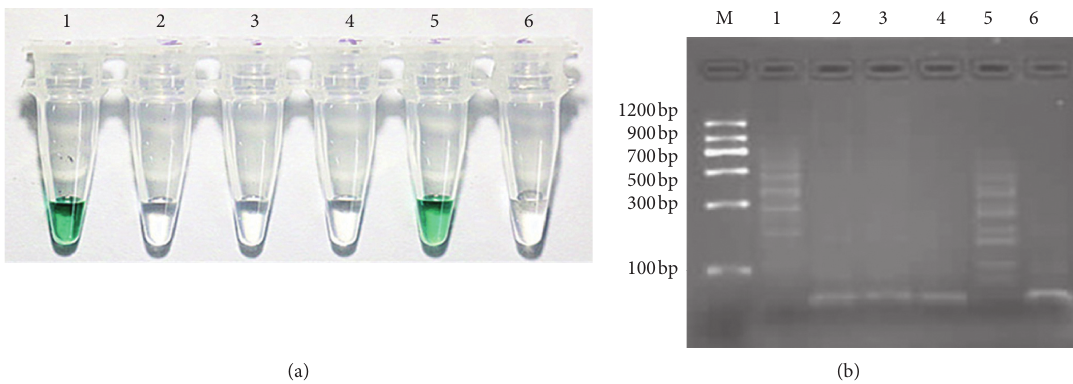
Figure 1: Colorimetric detection of the GmSg-1 a and GmSg-1 b using the HCR assays. (a) The photograph illustrates the colorimetric results of tubes 1–6 by adding different hairpin probes and target genes. Tube 1: GAa1+GAa2+TAa. Tube 2: GAa1+GAa2+TAb. Tube 3: blank. Tube 4: GAb1+GAb2+TAa. Tube 5: GAb1+GAb2+TAb. Tube 6: blank. (b) The corresponding results of 3% agarose gel